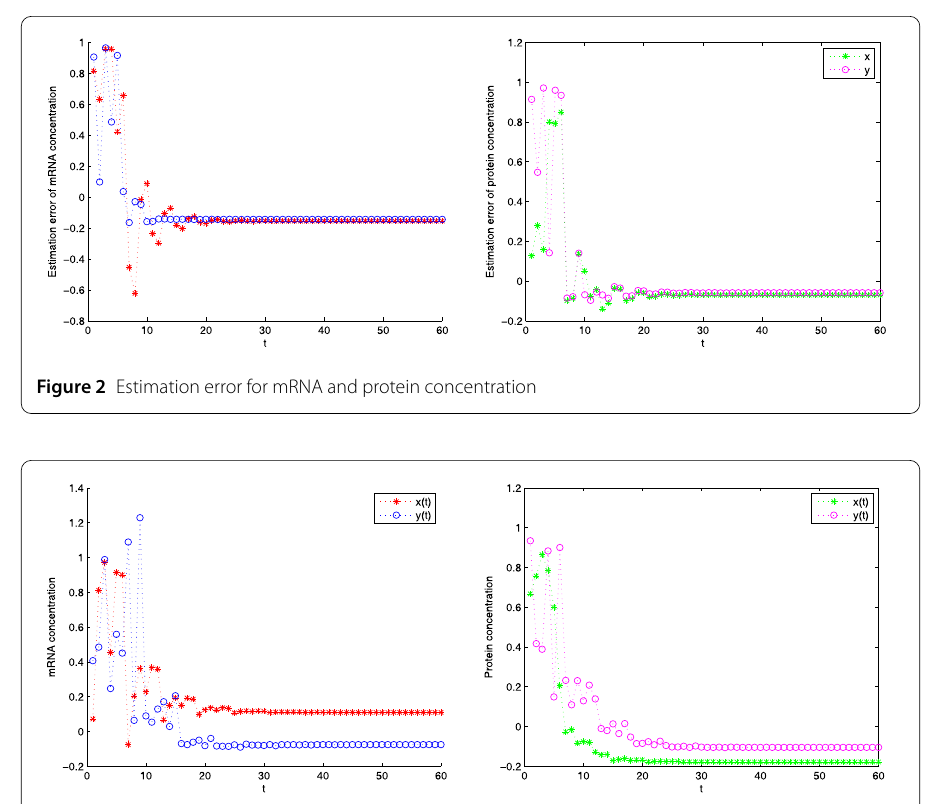
Figure 3 The state response x ( t ), y ( t ) of equation (47) with the mRNA and protein